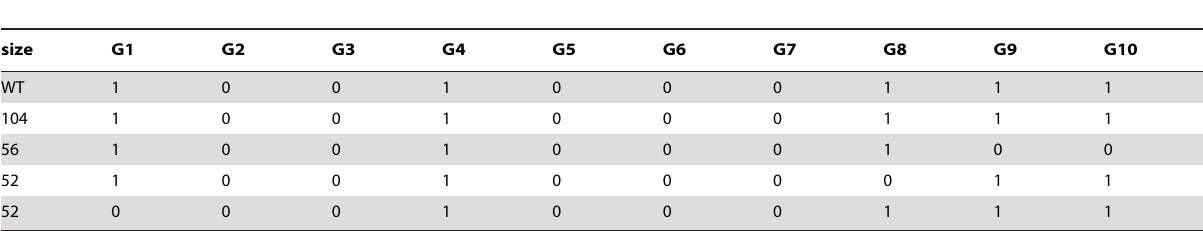
Table 8. Four largest attractors of the network.